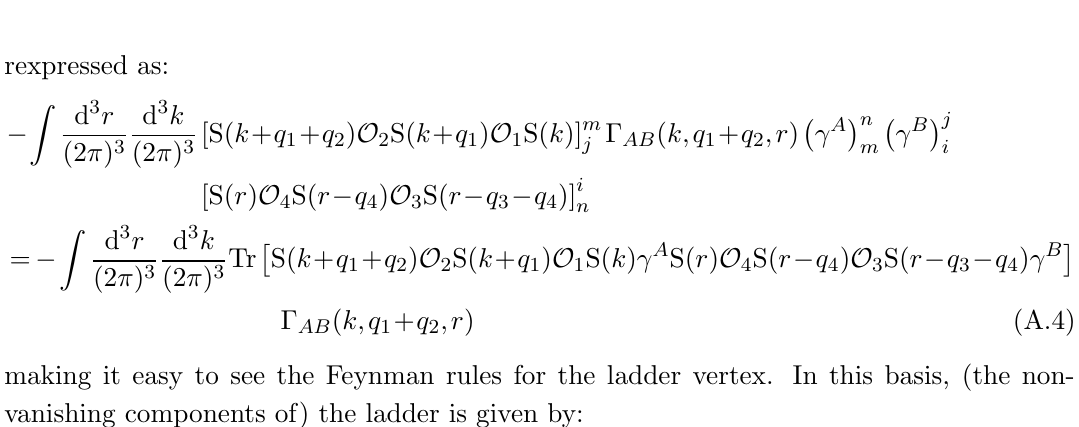
Figure 5. The sum of ladder-type diagrams. The fermion lines stand for exact fermionic propa- gators, and the ziplines stand for gluon